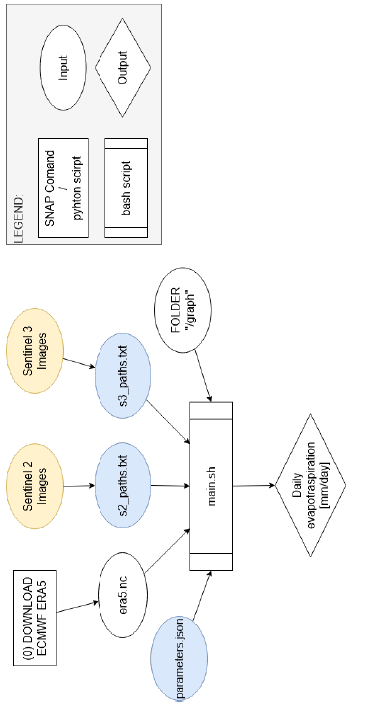
Figure 2. Sen-ET procedure automated.